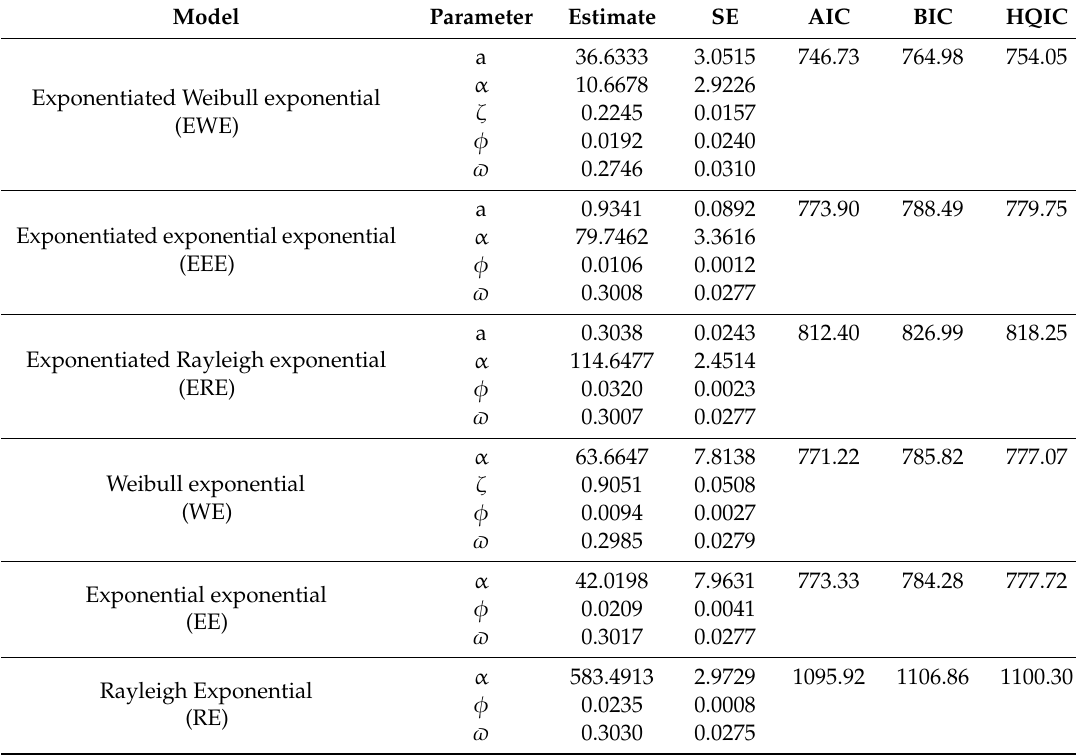
Table 1. Results of maximum likelihood estimates, considering the mixture cure model (MCM) for e1684 data without